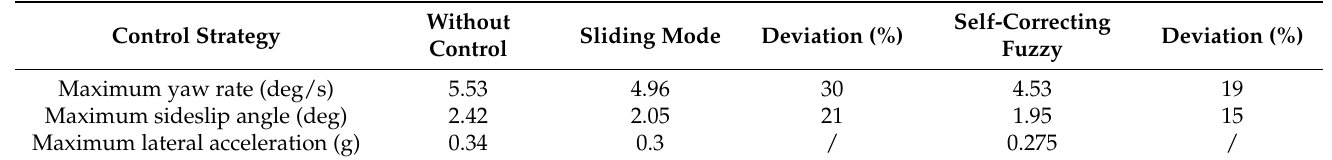
Table 6. The maximum values of the main control parameters under the high-speed small-steering- angle step